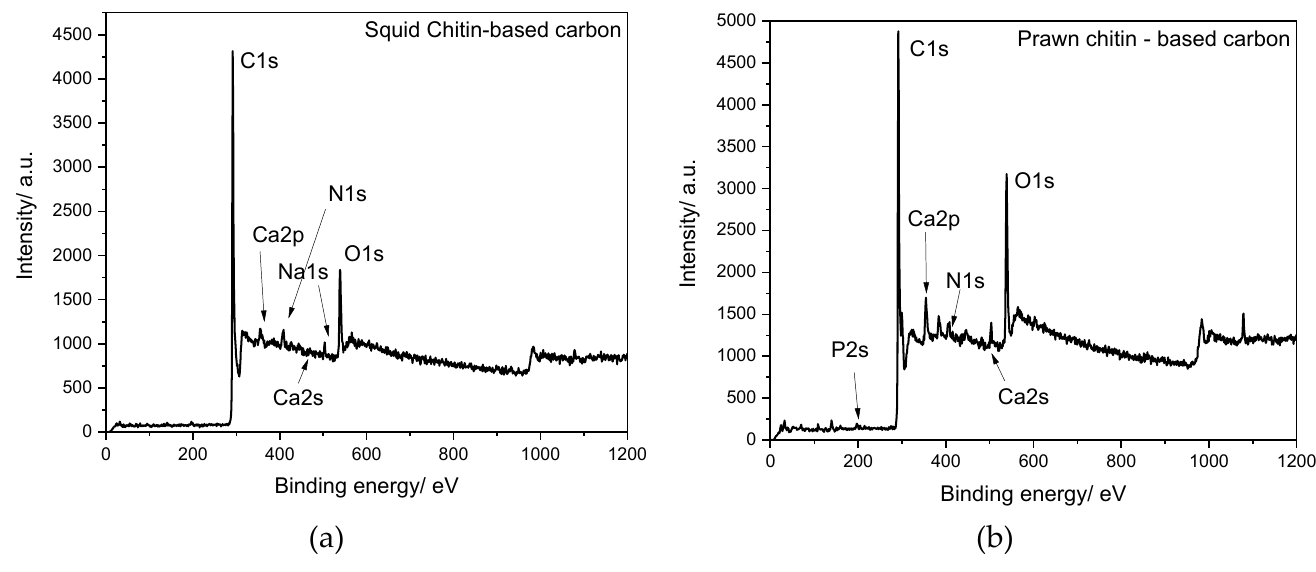
Figure 3. Overall XPS survey spectra for squid ( a ) and prawn ( b ) chitin-based carbon carbonized for 1 h at 1000 °C. Table 1. At% composition of the elements presented in the squid and prawn chitins-based carbons. At% Chitin-Based Carbons Raw